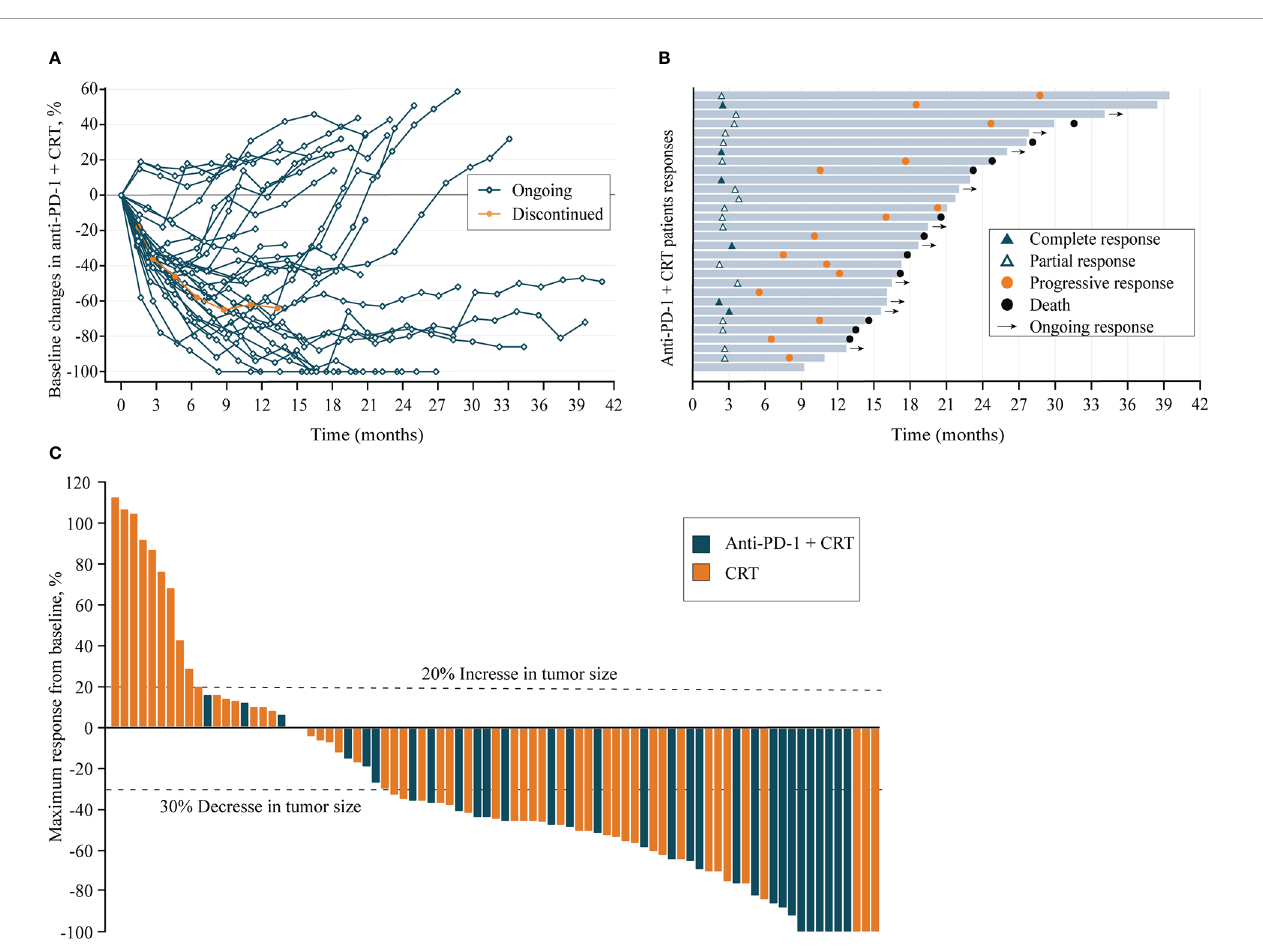
FIGURE 2 (A) , Longitudinal change in sum of longest target lesion diameters from baseline in Anti-PD-1+CRT group (n=30); (B) , Duration of exposure and response in Anti-PD-1+CRT group (n=30); (C) , Best change from baseline in sum of longest target lesion diameters per patient (n = 81). Anti-PD-1,